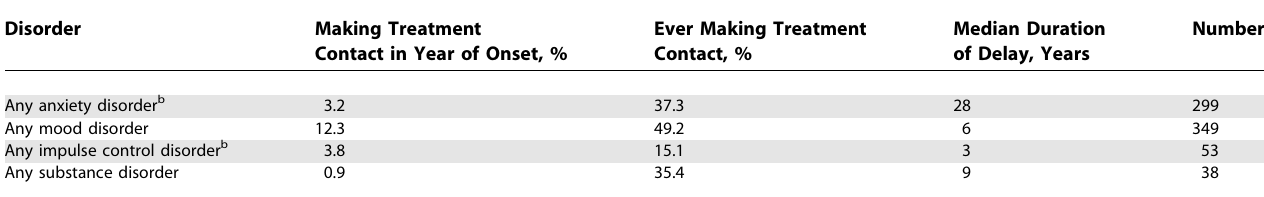
Table 4. Proportional Treatment Contact in the Year of Disorder Onset and Median Duration of Delay among Cases That Subsequently Made Treatment Contact